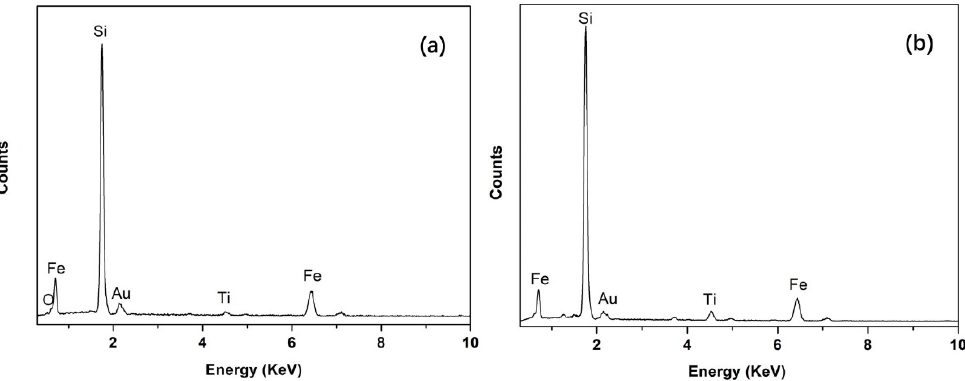
Figure 4. Typical EDS analysis of the bright Fe-concentrated phase at the silicon-slag interface ( a ) and within the silicon droplet ( b ). Table 5. Composition of impurity phases in silicon droplet in Figure 3, wt%.